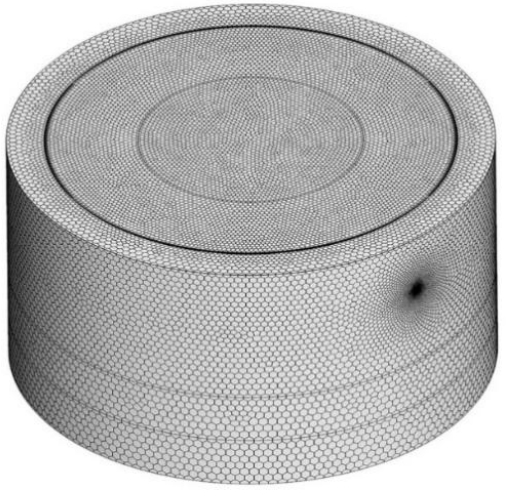
Figure 4. The mesh of the computational model.